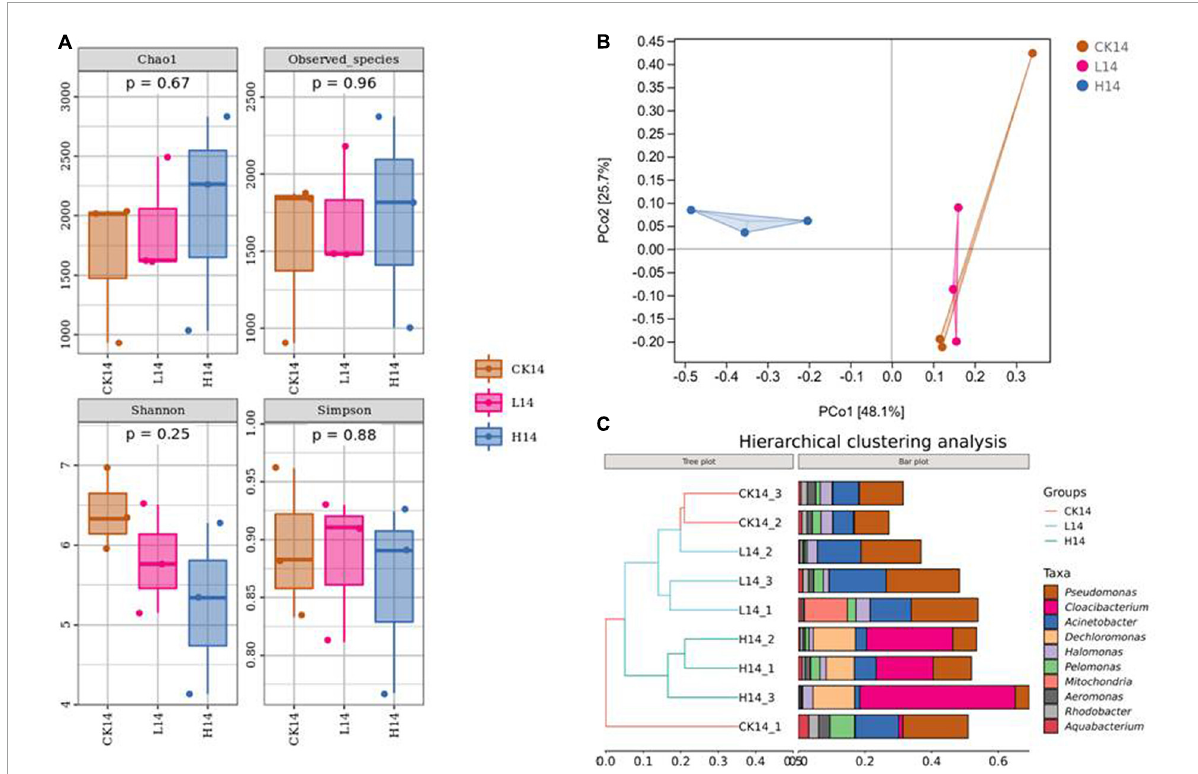
FIGURE2 Intestinal microbiome diversity in the control (CK14), 0.5 mg/L (L14) and H14 (1.5 mg/L) groups. (A) α -diversity comparisons in the intestinal microflora among the CK14, L14, and H14 groups. (B) Bray–Curtis distances were calculated and visualized through Principal Coordinate Analysis (PCoA) (Ellipses were drawn with 95% confidence intervals). (C) Hierarchical cluster analysis of the Bray–Curtis distances generated from taxa tables showed Amplicon Sequence Variant (ASV) similarity across microbial communities among different